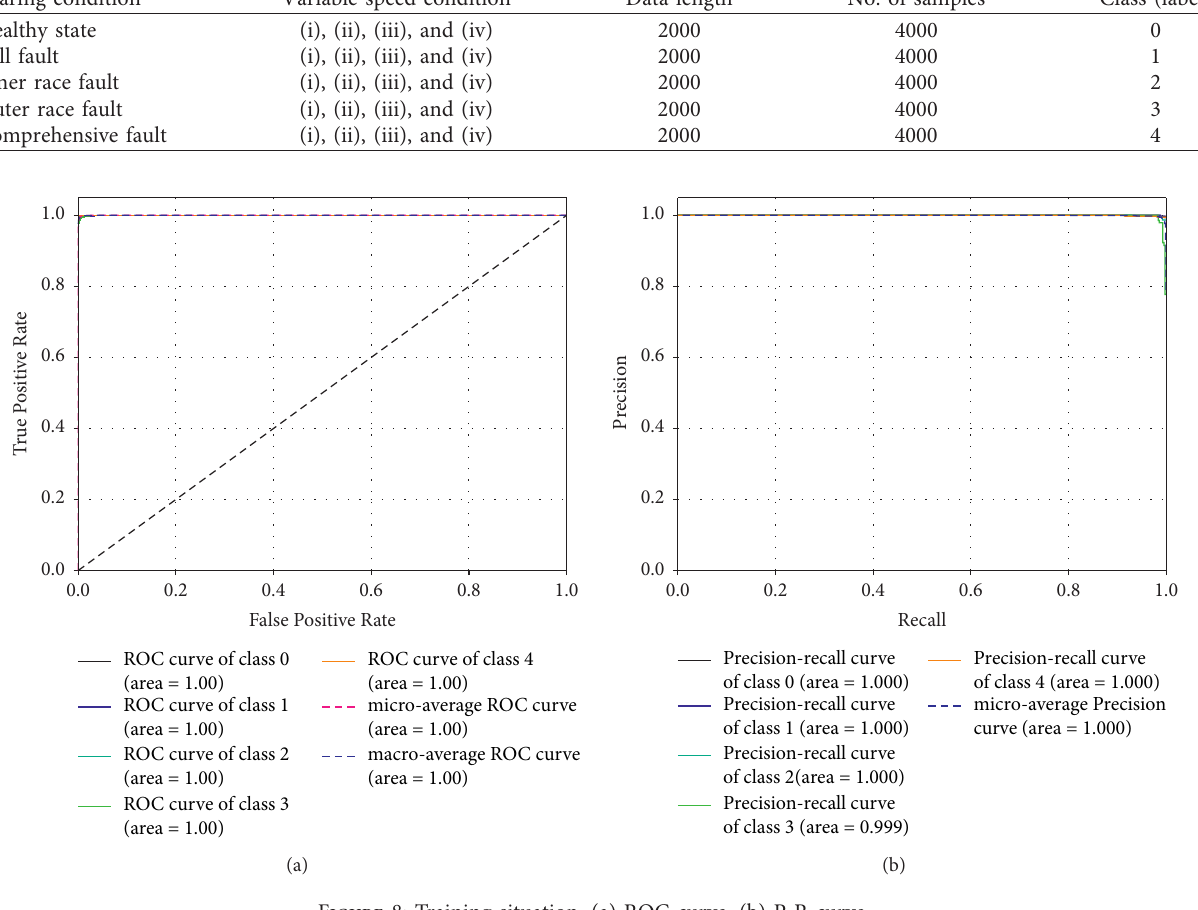
Figure 8: Training situation. (a) ROC curve. (b) P-R